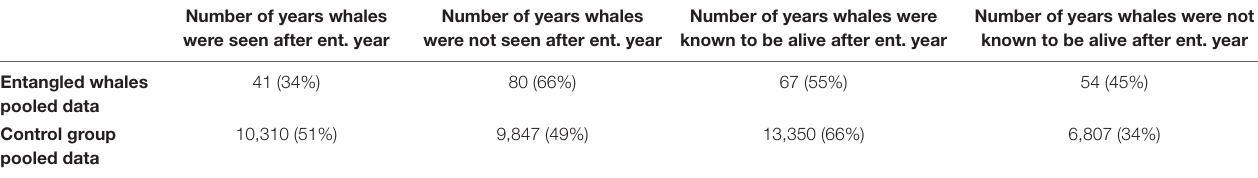
Number of years whales were not known to be alive after ent. year